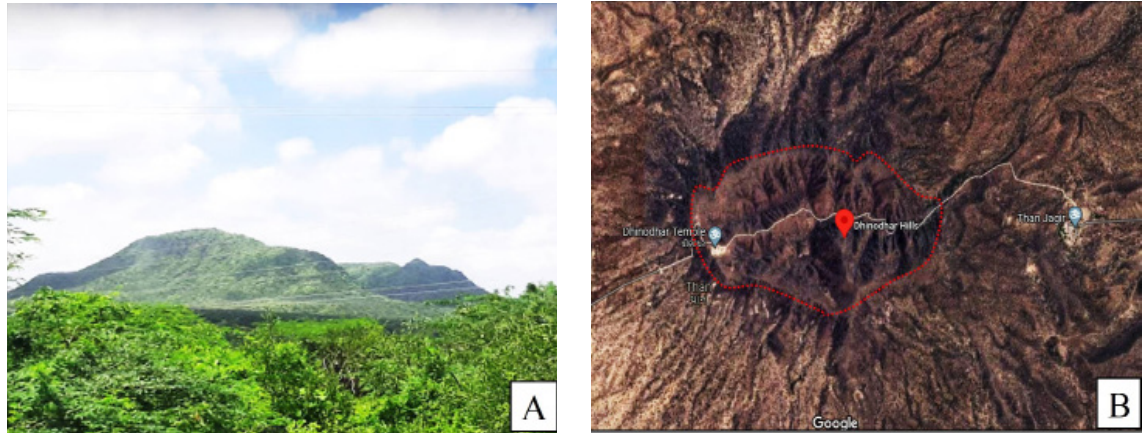
Figure 8. Dhinodhar hill volcanic plug; A) scenic view, and B) aerial view taken from Google